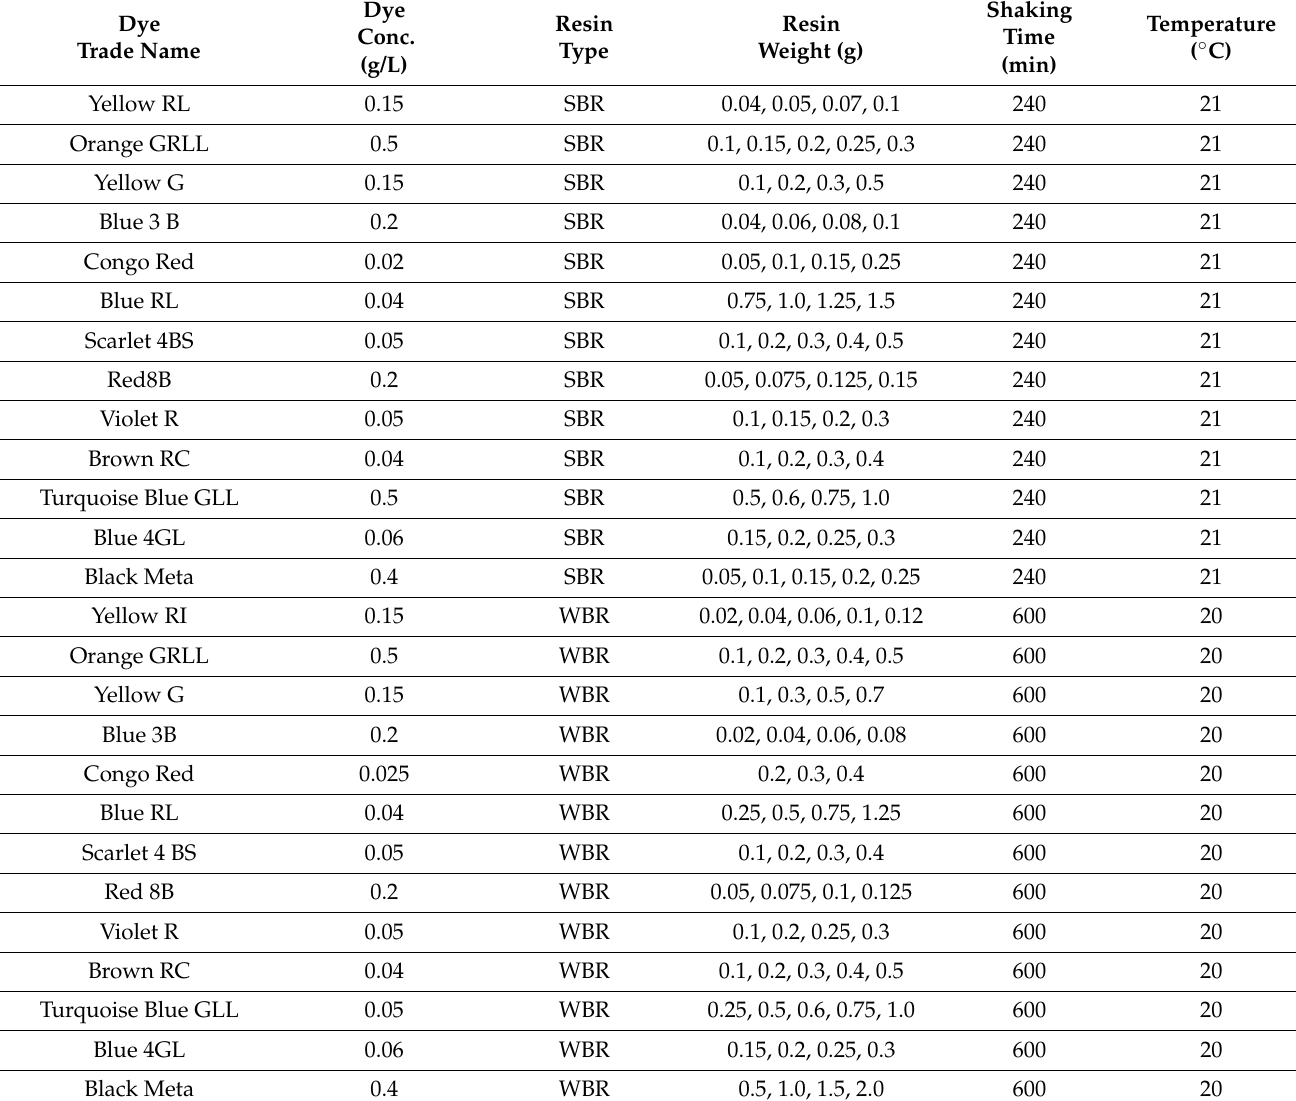
Table 8. Experimental conditions for batch